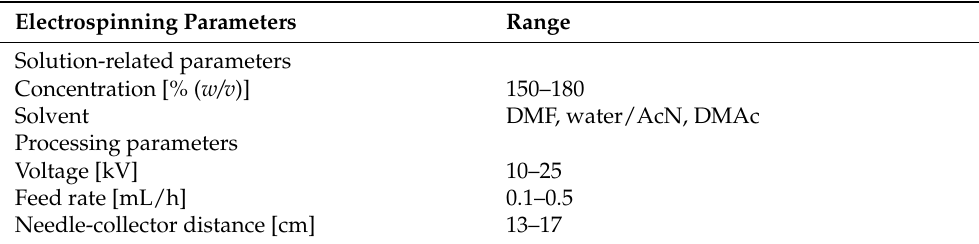
Table 1. Process-related parameters applied for the electrospinning of CDLA solutions. Electrospinning